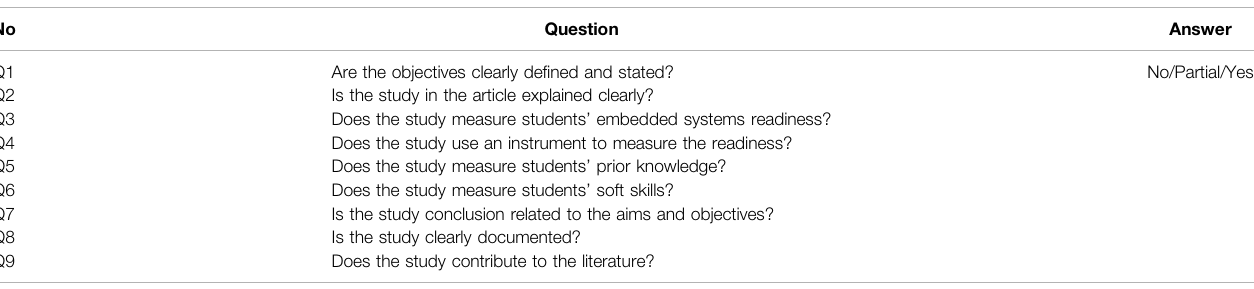
TABLE 8 | Quality assessment questions for the RM group.